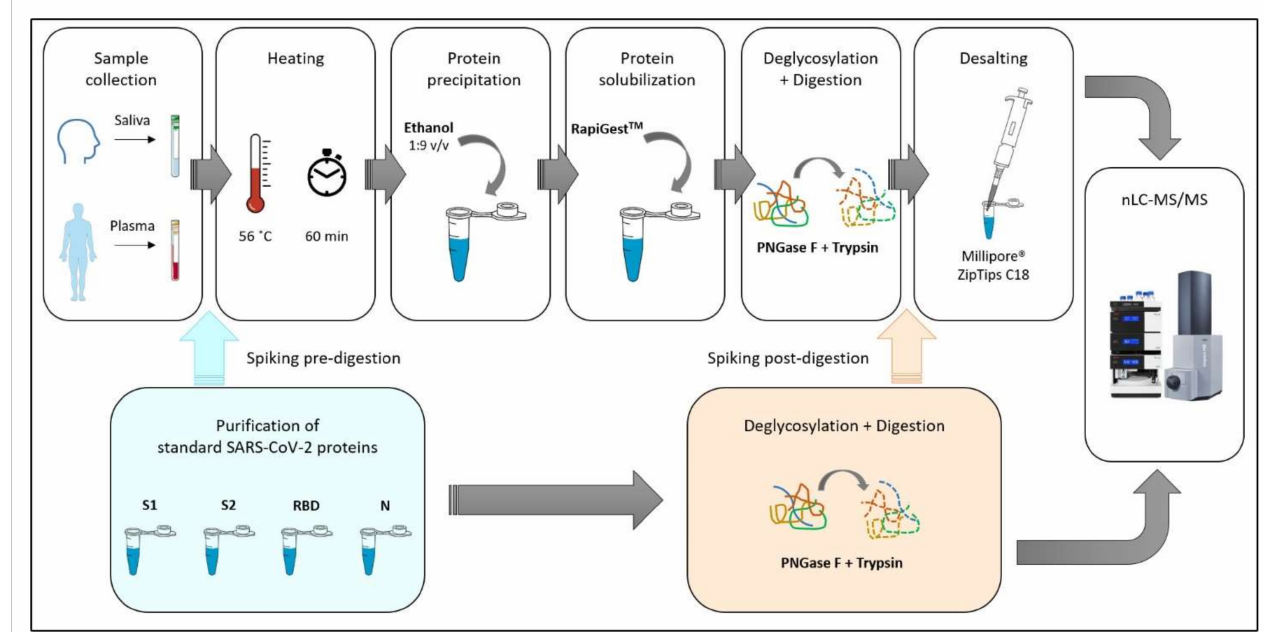
Figure 1. Experimental workflow. Graphic illustration of all the steps involved in sample preparation and analysis of the data. Saliva and plasma samples underwent a process of virus inactivation, followed by deglycosylation and protein digestion, before being analysed by nLC-ESI-MS/MS. Some of them were spiked with purified SARS-CoV-2 proteins before inactivation or after